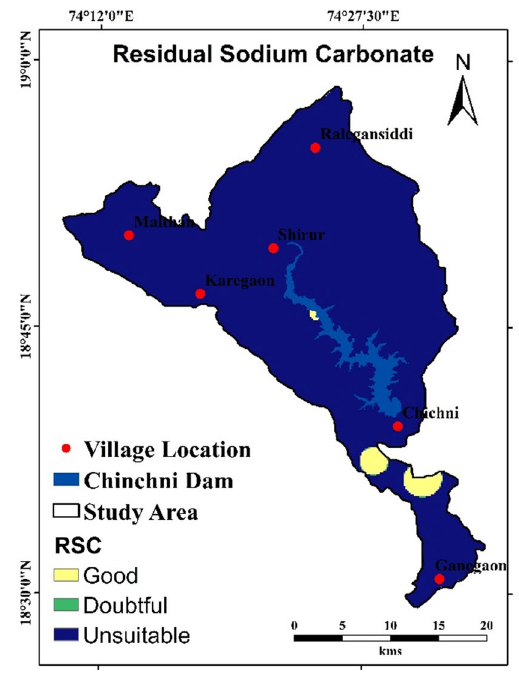
Fig. 12 Spatial variation in RSC